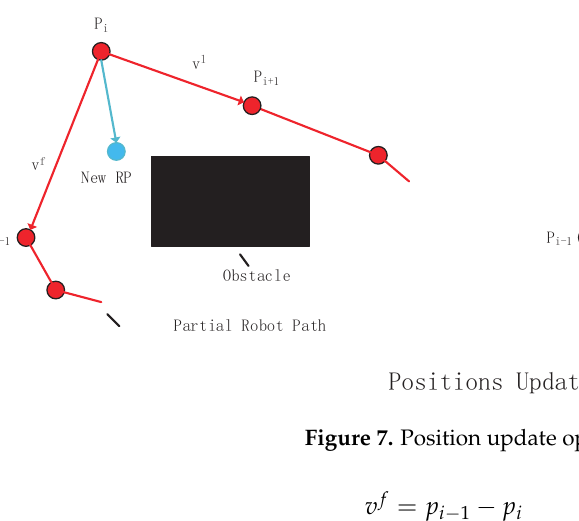
Figure 7. Position update